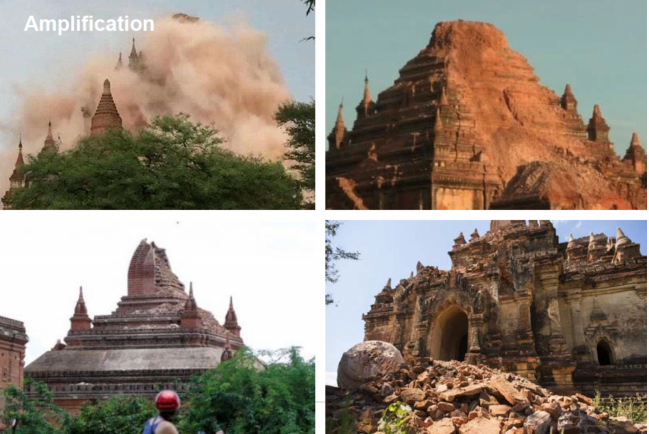
Figure 5. Amplification effects during the 2016 Bagan earthquake in Myanmar.